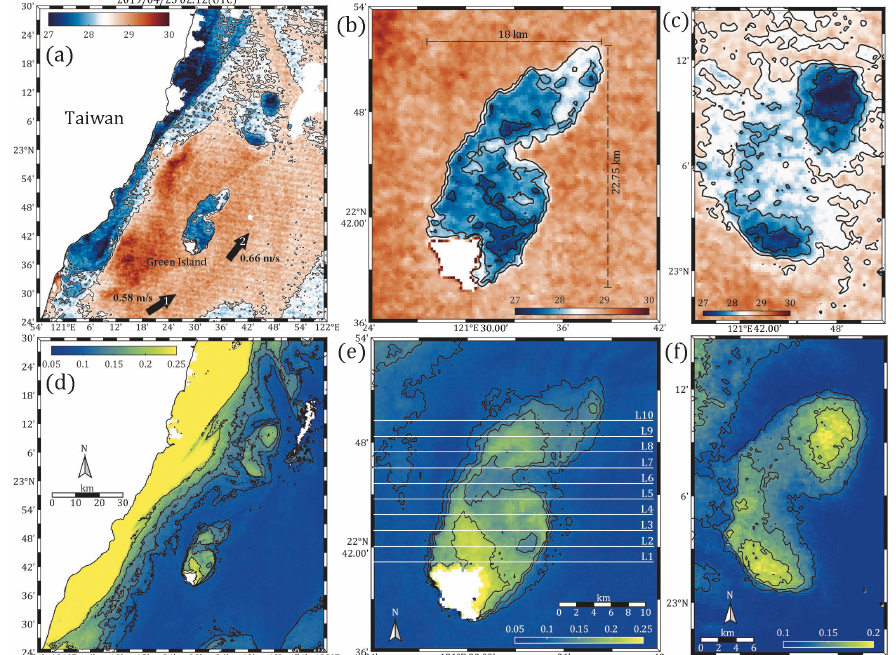
Figure 3. Case of the island vortex obtained from the global change observation mission (GCOM-C) second-generation global imager (SGLI) data taken at 02:12 (UTC), 25 April 2019. ( a ) Sea surface temperature (SST) ( ◦ C), ( b , c ) zoom in on vortices of ( a , d ) Chl-a (mg/m 3 ), ( e , f ) zoom in on vortices of ( d ). The black arrow in ( a ) is the current velocity from the OSCAR data. The first arrow (22.33 ◦ N, 121.33° E) has a speed of 0.58 m/s, and the second arrow (22.67° N, 121.67° E) has a speed of 0.66 m/s.